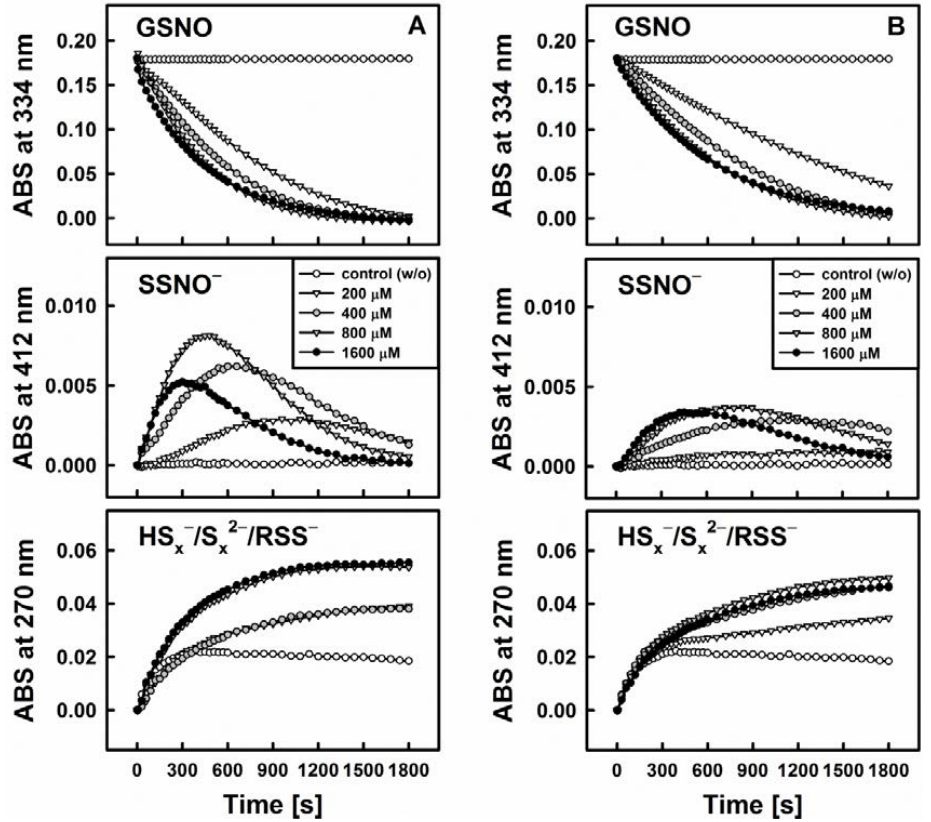
Figure 3. Kinetic traces of the interactions of 200 µM DATS with 200 µM GSNO in the absence and presence of various concentrations of cysteine (Cys, left, A ) and reduced glutathione (GSH, right, B ) monitored at three characteristic wavelengths by UV/VIS spectrophotometry (334 nm—GSNO decomposition, 412 nm—formation of SSNOˉ, 270 nm—formation of hydroper-/polysulfides). The maximum rate of GSNO decomposition was achieved at concentrations of 800 or 1600 µM Cys/GSH.